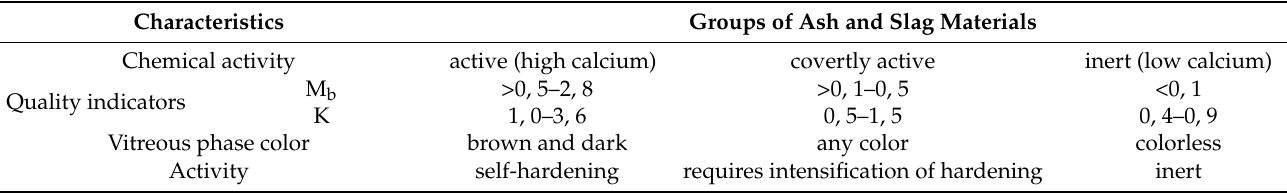
Table 1. Classification of coal ash by activity